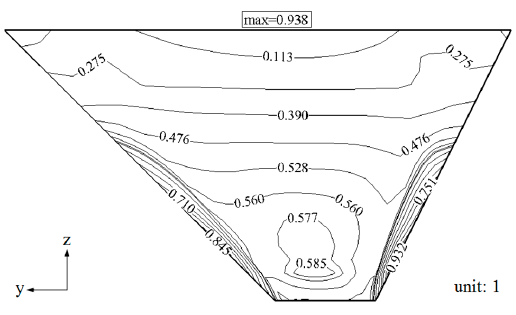
Figure 7. Stress level contours of ACC ( h = 200 m) .